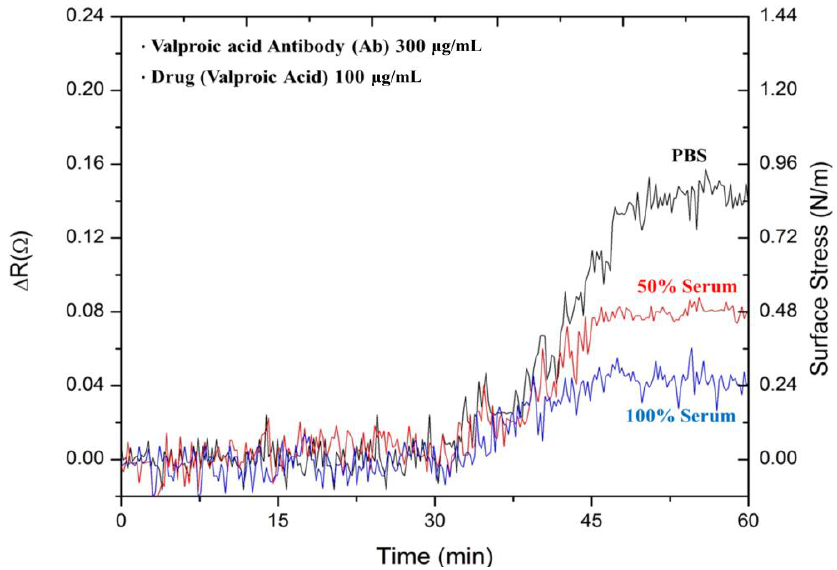
Figure 5. The measured results of 100 μg·mL −1 valproic acid in PBS, 50% serum and pure